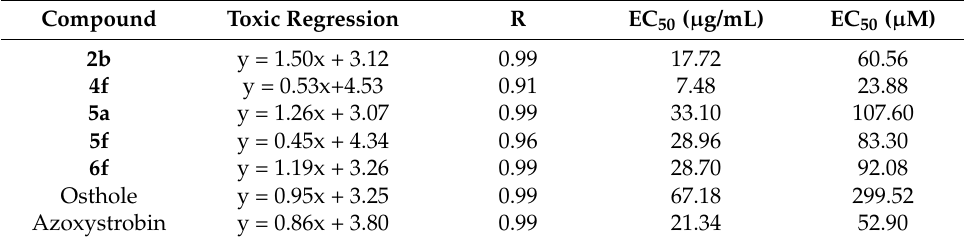
Table 4. EC 50 values determination of some target compounds against R. solani .